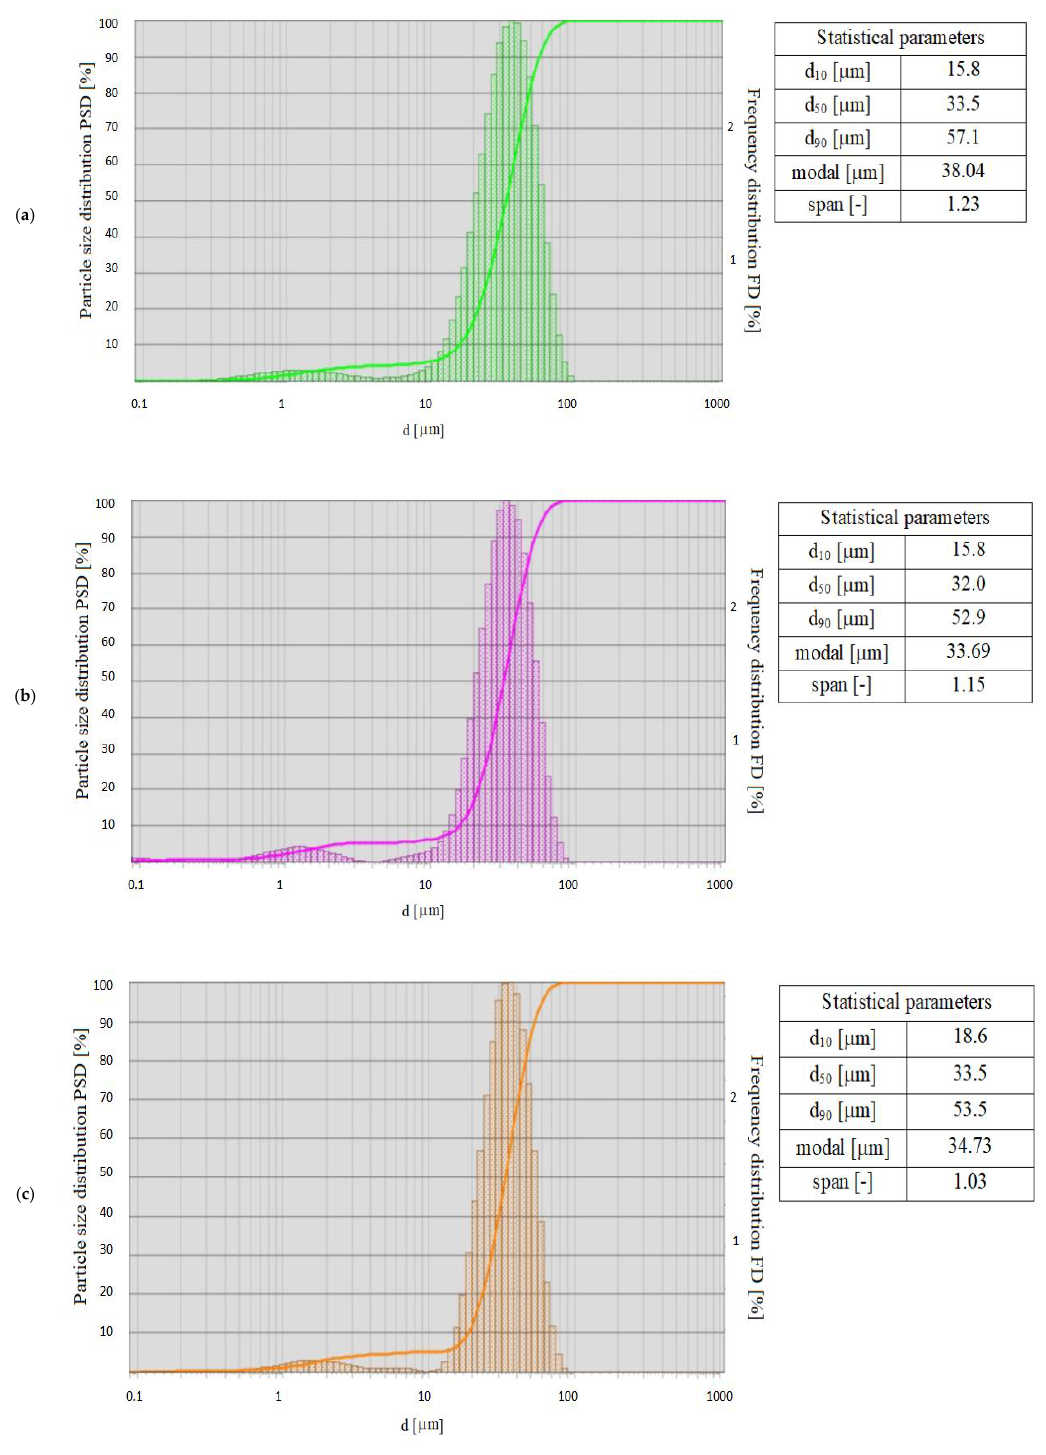
Figure 6. Sizes of characteristic particles determined with the use of the laser diffraction method in the samples of synthetic gypsum before the calcination process: ( a ) 1st measurement, ( b ) 2nd measurement, ( c ) 3rd measurement.